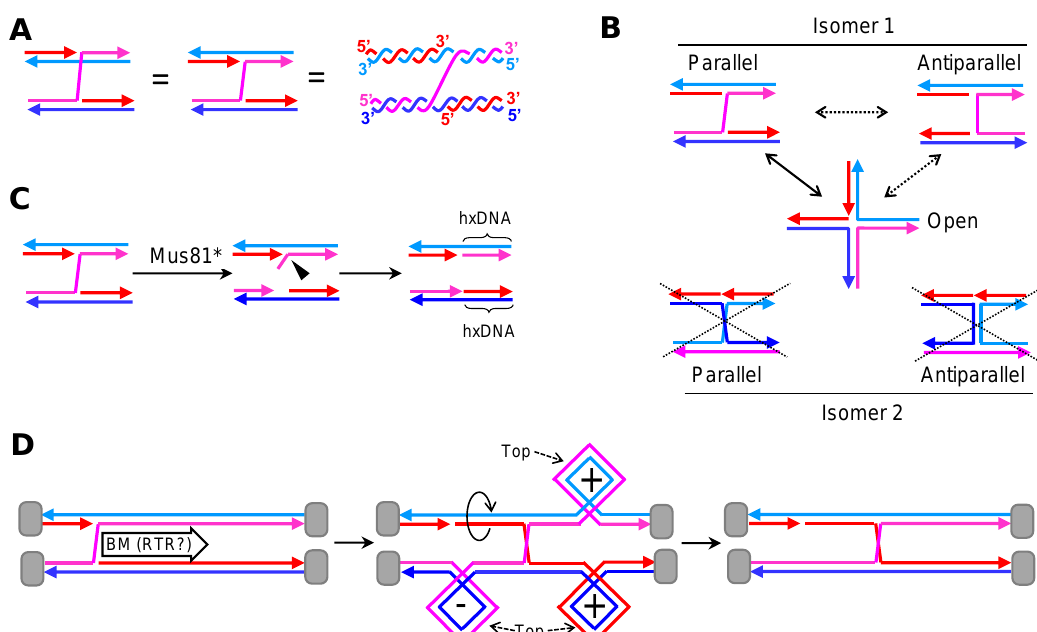
Figure 3. Features of the nicked Holliday junction (nHJ). ( A ) 2D schematics of the nHJ in the parallel conformation. ( B ) The nHJ can exist as one isomer, in which the crossover strand corresponds to the homolog to that with the nick. The nHJ tends to adopt the open conformation. ( C ) The nHJ is the target of a specialized nHJ resolvase, Mus81*, which cuts the crossover strand near the cross-join, leading to two daughter molecules, one with a 5 (cid:48) flap and one with a gap. The flap and the gap can be further processed in vivo, so the resulting molecules are like one of the two solutions shown in Figure 2F, including the hxDNA flank. ( D ) Branch migration can isomerize a nHJ into a cHJ. In topologically constrained molecule ends (grey boxes), branch migration results in positive supercoiling ( + ) ahead and negative supercoiling ( − ) behind the migration direction. In principle, the nick left behind in one strand may relieve negative supercoiling through swirling (turning arrow). For other details see the legend of Figure 2. BM, Branch